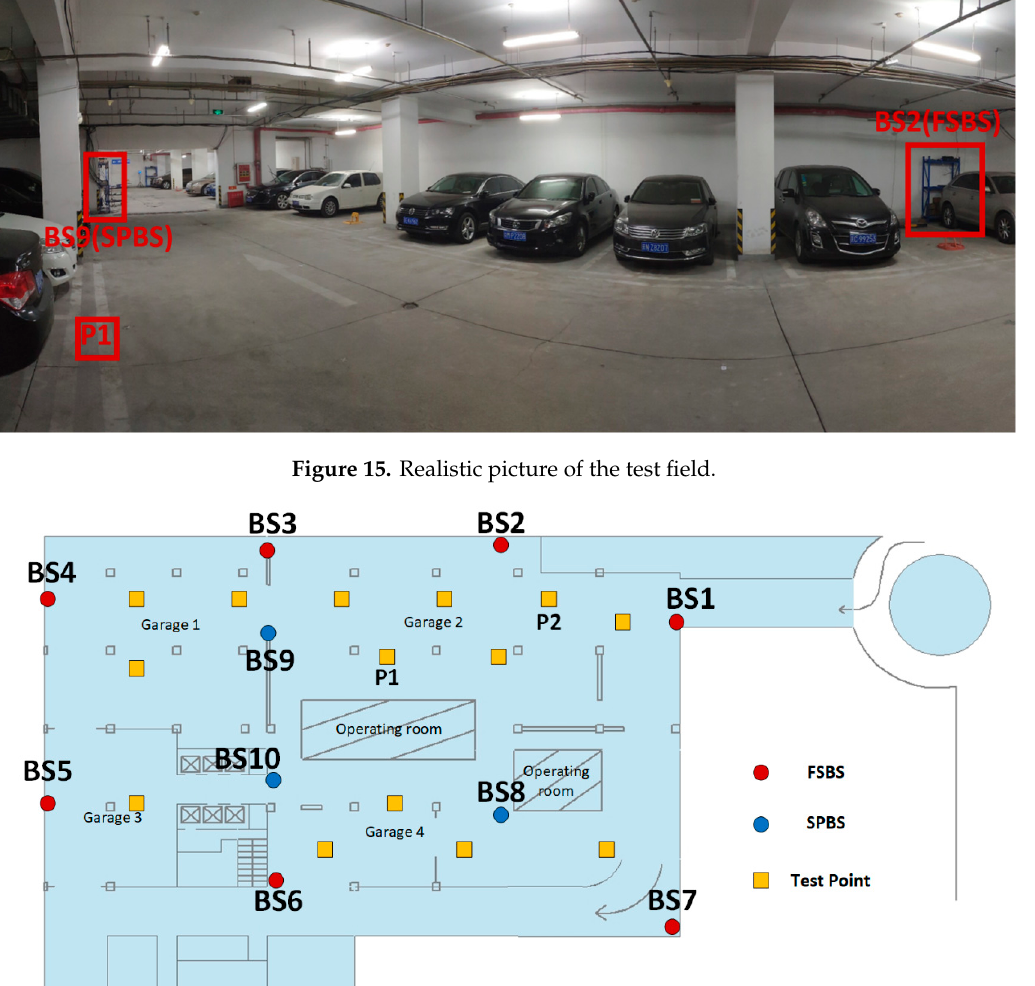
( c ) Figure 17. ( a ) External structure of FSBS positioning module; ( b ) internal structure of FSBS positioning module; ( c ) FSBS.